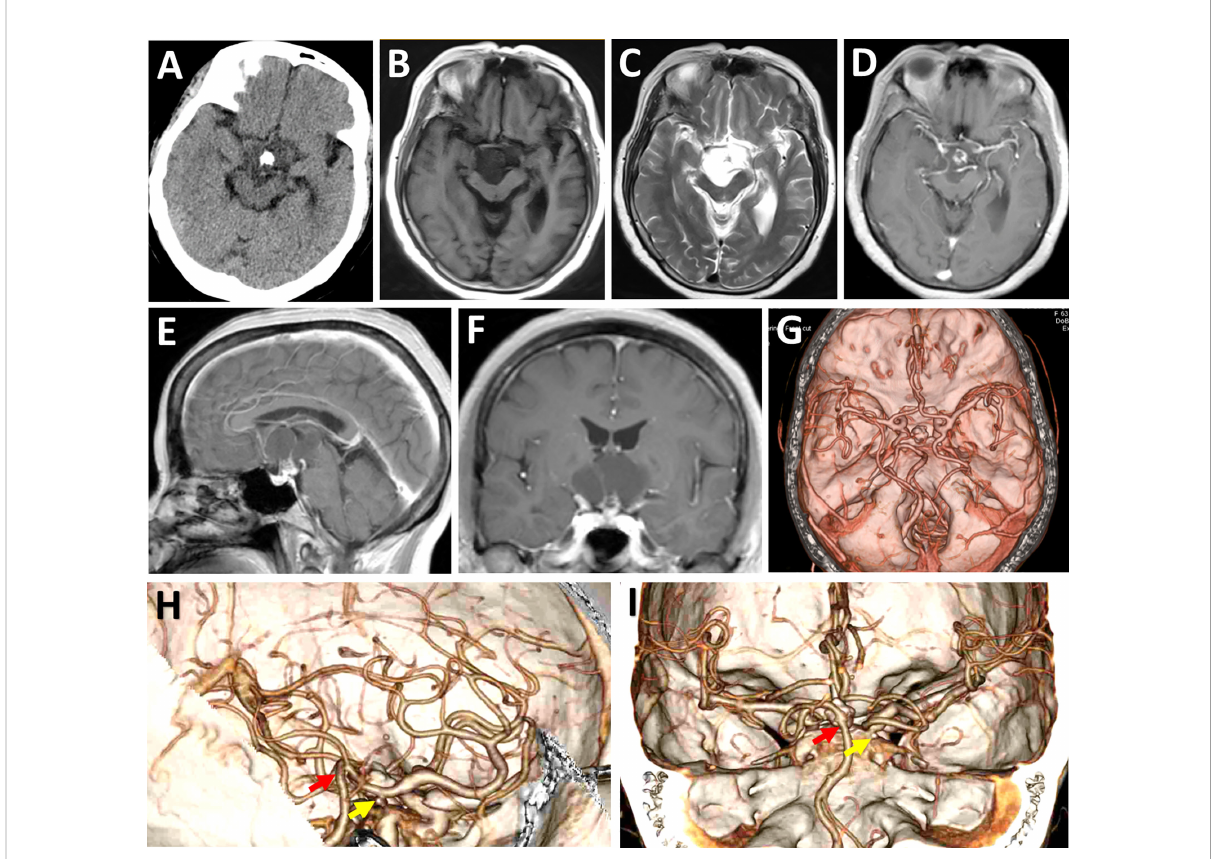
FIGURE 2 Radiological evaluation ofthe suprasellar lesion preoperatively. (A-F) Preoperative CTand MRI scans showinga typical retroinfundibular CP. This lesion manifested as a hypodense irregular mass withcalci fi cation located in the suprasellar lesion (A) , which was hypo-intense onT1WI (B) and hyper- intense onT2WI (C) . Post-contrast (gadolinium-enhanced) axial (D) , sagittal (E) , and coronal (F) MRI showed a thick, irregular enhancement of the solid partand a slight rim enhancement of the cystic component. (G-I) Preoperative axial (G) , sagittal (H) , and coronal (I) CTangiography images showed the relative locationof the tumor to the Willis ’ circle. Note that in this patient the basilar apex was at a higherpositionsurpassingthe posterior clinoid process. The yellow arrows denote posteriorclinoid process, whilethe red arrows depict the basilar